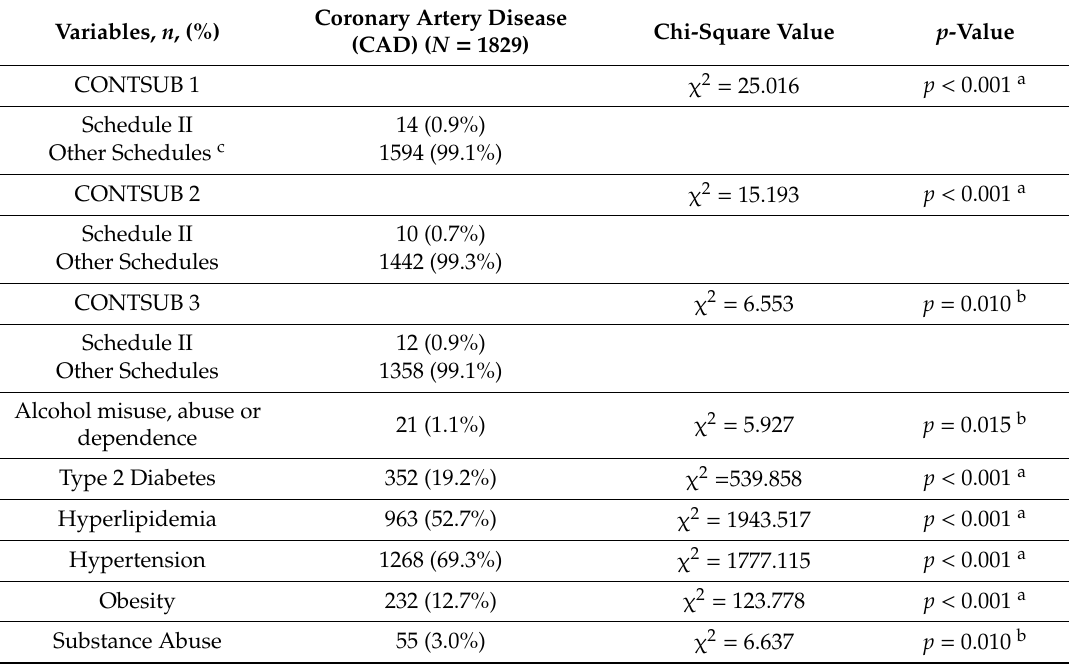
Table 2. Chi-square test of independence for certain risk factors of Coronary Artery Disease